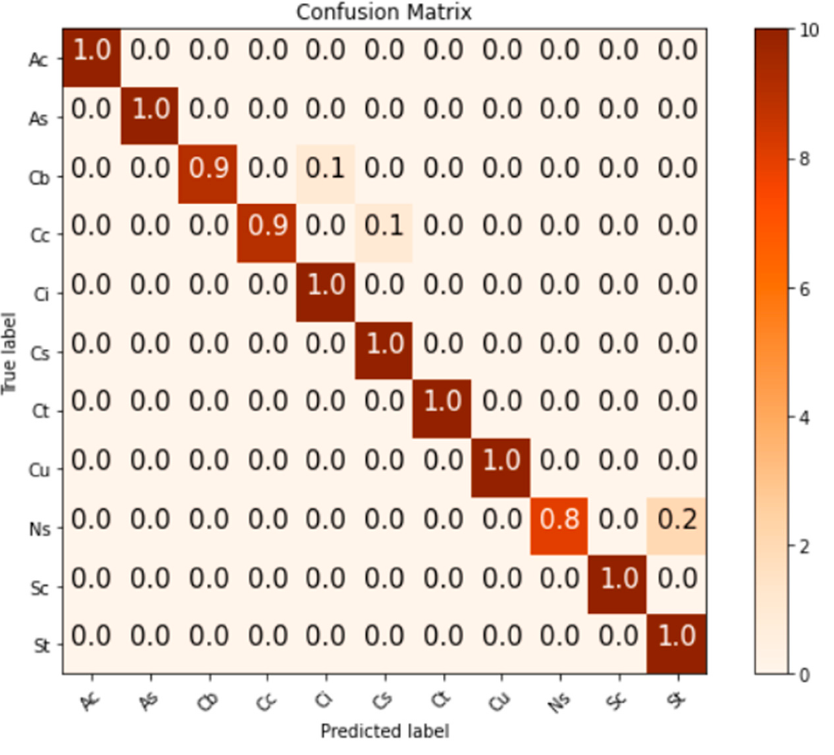
Figure 7. Sample predicted cloud, class, and array . Based on 11 classes (0~10) from the reference sample picture in Figure 7, the model generated a prediction on index 0, since it had the highest confidence level of 99.99%, that the image class was 0. The model’s percentage confidence for each class on the image sample provided in Figure 7 is shown in Table 3. Table 3. Outline of the model’s percentage confidence for the predicted Figure 8 sample image. Label/Classes